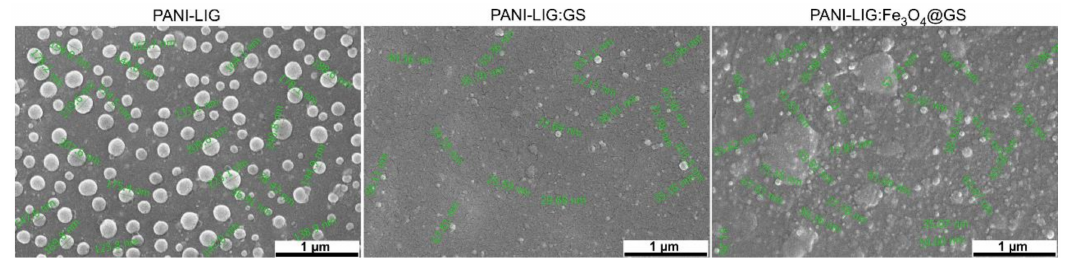
Figure 3. Scanning electron microscopy (SEM) micrographs of PANI-LIG-based